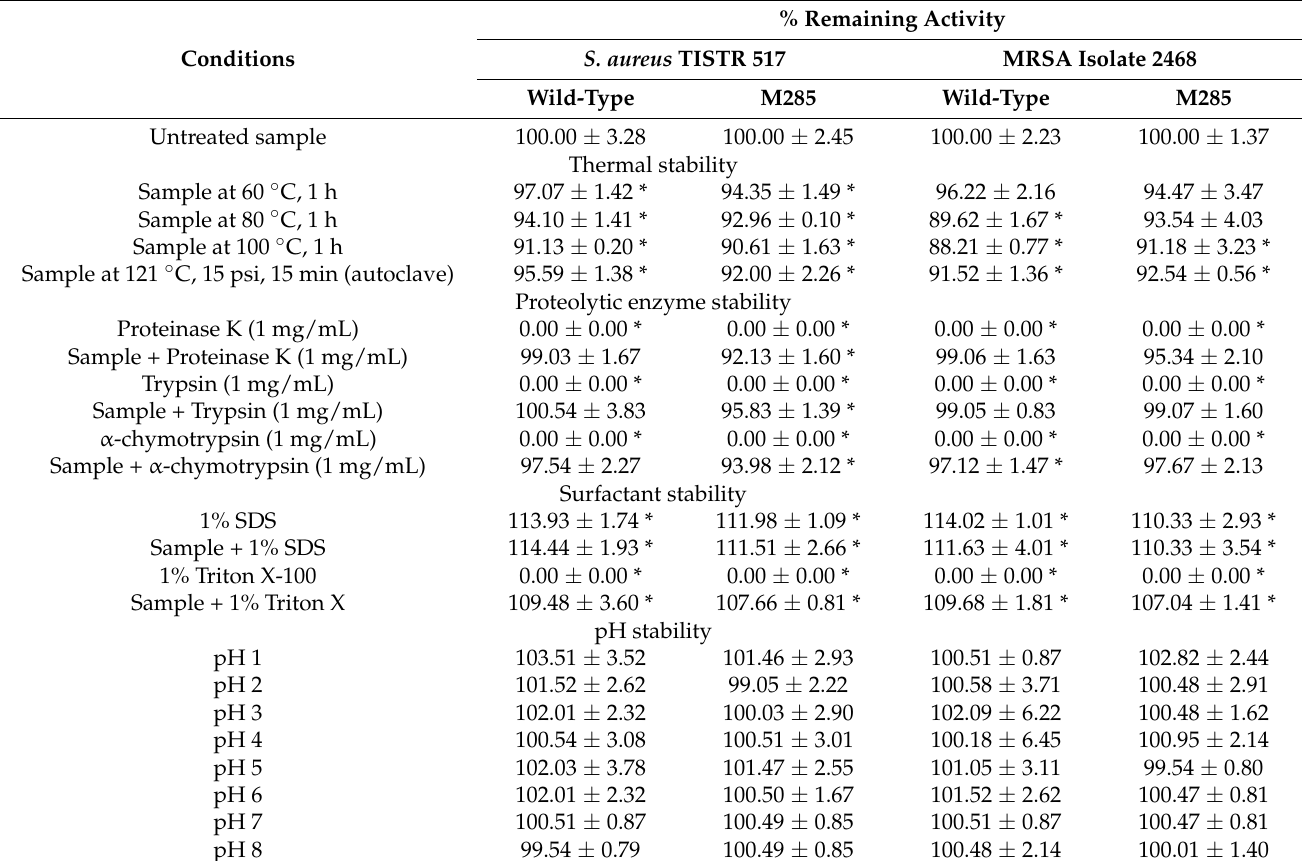
Table 4. Stability study of antibacterial substances of the wild-type and M285 strains. The percent of the remaining activity was calculated, and expressed as mean ± SD ( n =